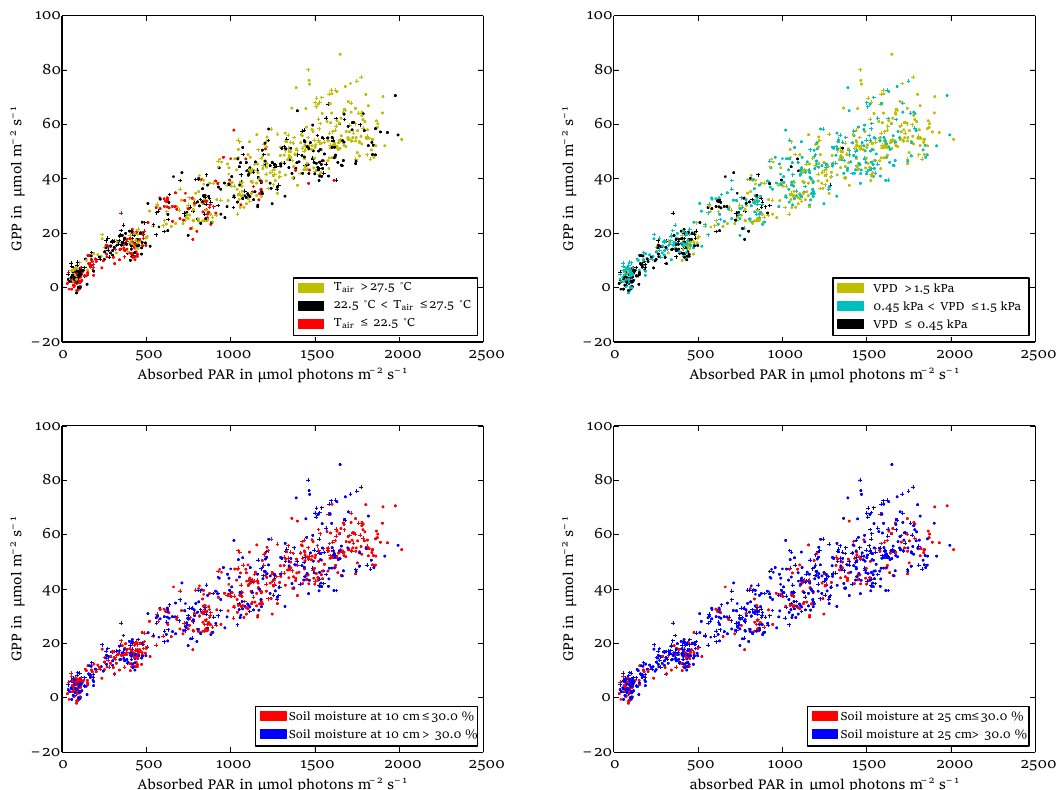
Figure 20. Hourly FLUXNET GPP data (in µmolCO 2 ( m 2 ground ) − 1 s − 1 ) against observed Absorbed Photosynthetically Active Radiation (APAR) (in µmolphotons ( m 2 ground ) − 1 s − 1 ). LAI is between 3.5 and 4.5 and all points have DVI less than 1. Dots and vertical crosses (+) indicate US-Ne1 and US-Ne2 respectively. Colour indicates air temperature (top left), vapour pressure deficit (top right), soil water content at 10cm (lower left) and soil moisture content at 25cm (lower